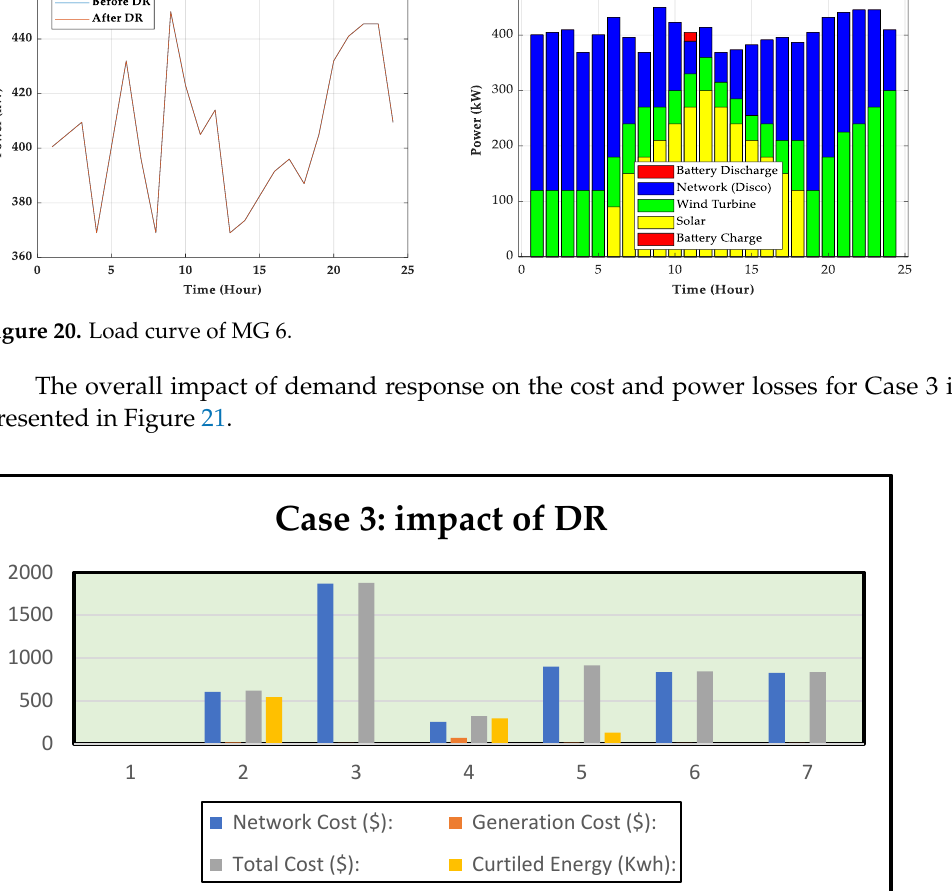
Figure 23. Impact of DR and power-sharing on MG 2. MG 3, having a commercial load, has a nominal change in power losses and the cost due to the implementation of DR and power-sharing. The impact is shown in Figure 24. Power-sharing has the advantage of sharing extra energy among the microgrids and the main grid, and wastage of energy is prevented. Figure 24. Impact of DR and power-sharing on MG 3. MGs 4 and 5 have residential loads, and the impact of both demand response and power-sharing is shown in Figure 25. The sharing of power among microgrids helps them